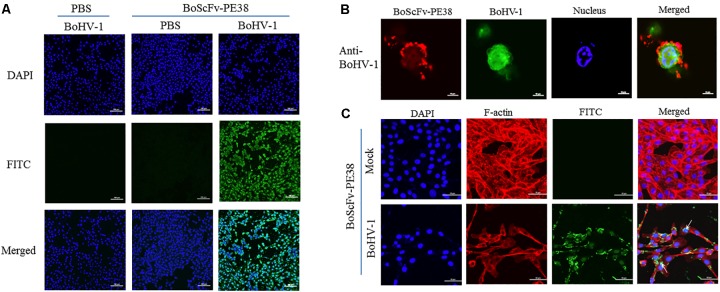
Binding specificity and internalization of BoScFv-PE38 in BoHV-1-infected MDBK cells. (A) Recognition of BoScFv-PE38 to BoHV-1 infected in MDBK cells was determined via IFA. MDBK cells were seeded on cover slips in six-well plates and cultured to 50% confluency at 37°C over 18–24 h. Then, the MDBK cells were infected with BoHV-1 (MOI = 1). After 1.5 h, the culture medium was replaced by new culture medium containing 1% FBS and BoScFv-PE38 (1 μM), and the MDBK cells were cultured for 24 h. The MDBK cells were fixed with 4% paraformaldehyde, permeabilized with 0.1% Triton X-100 for 1 h, blocked with 3% bovine serum albumin, incubated with the anti-His McAb for 1 h at 37°C, and then incubated with the FITC-goat anti-mouse antibody for 1 h at 37°C. The nuclei were counterstained with DAPI (blue). The cell samples were examined with a fluorescence microscope (Leica EL 6000). (B) Location of BoScFv-PE38 in BoHV-1-infected MDBK cells was determined via CLSM. MDBK cells were seeded on cover slips in six-well plates and cultured to 50% confluency at 37°C over 18–24 h. Then, the MDBK cells were infected with BoHV-1 (MOI = 1). After 1.5 h, the culture medium was replaced with new culture medium containing 1% FBS and BoScFv-PE38 (1 μM), and the MDBK cells were cultured for a further 24 h. The MDBK cells were then fixed with 4% paraformaldehyde, permeabilized with 0.1% Triton X-100 for 1 h, blocked with 3% bovine serum albumin, incubated with the anti-gD mAb or anti-BoHV-1 bovine serum for 1 h at 37°C, washed three times with PBS, incubated with the FITC-labeled goat anti-mouse antibody or the FITC-labeled rabbit anti-bovine antibody at 37°C for 1 h, washed three times with PBS once more, and finally incubated with the Alexa Fluor 555- anti-His antibody at 37°C for 1 h. The nuclei were counterstained with DAPI (blue). The cell samples were observed under a confocal laser-scanning microscope (Leica). (C) The internalization of BoScFv-PE38 entrapped by BoHV-1. MDBK cells were infected with BoHV-1 (MOI = 1). After 1.5 h, the culture medium was replaced with new culture medium containing 1% FBS and BoScFv-PE38 (1 μM), and the MDBK cells were cultured for 24 h. MDBK cells were fixed with 4% paraformaldehyde, permeabilized with 0.1% Triton X-100 for 1 h, and blocked with 3% bovine serum albumin. The cells were then incubated with the anti-His mAb for 1 h at 37°C, washed three times with PBS, and incubated with the FITC-labeled goat anti-mouse antibody at 37°C for 1 h. Cellular F-actin was stained with Alexa Fluor 555-conjugated phalloidin. The nuclei were counterstained with DAPI (blue). Normal MDBK cells were used as the negative control. Cell samples were examined with a confocal laser-scanning microscope (Leica). The white arrows indicate BoScFv-PE38 in the nucleus and cytoplasm of BoHV-1-infected MDBK cells.